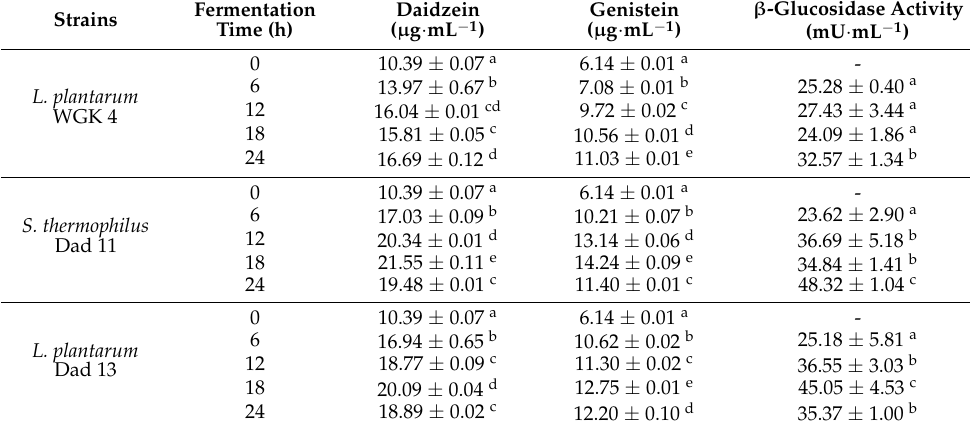
Table 7. Isoflavone aglycone (daidzein and genistein) and β -glucosidase activity of black soy milk during fermentation by Indonesian indigenous LAB (24 h, 37 ◦